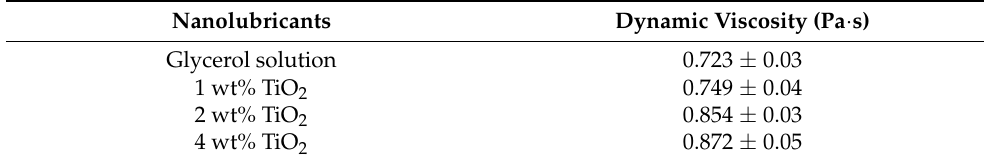
Figure 4. XRD pattern of TiO 2 NPs.